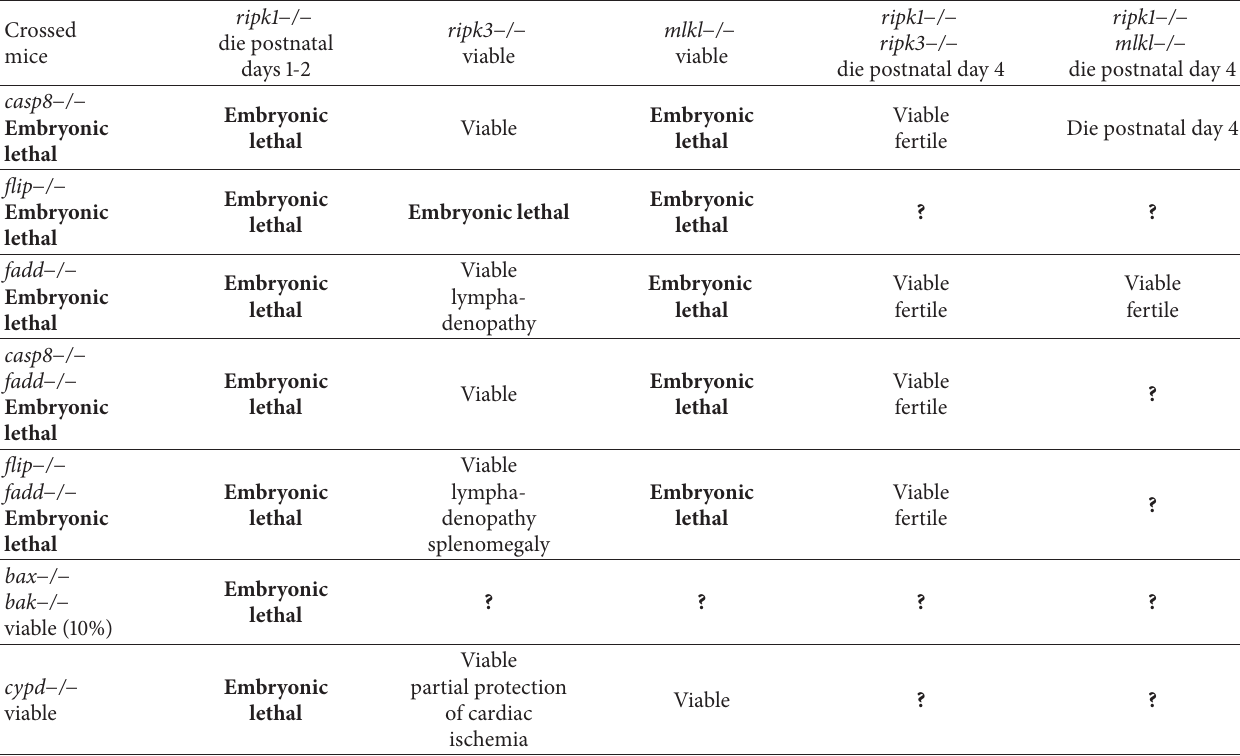
Table 1: Summary of phenotypes of double- and triple-knockout mice ablated for genes that regulate apoptotic and necroptotic cell death pathways.